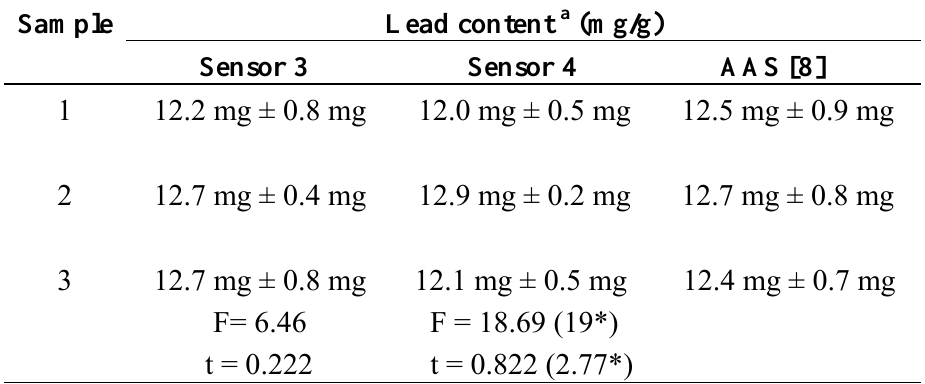
Table 6. Determination of lead in galena rock by using potentiometric sensors and atomic absorption spectrometry (AAS)